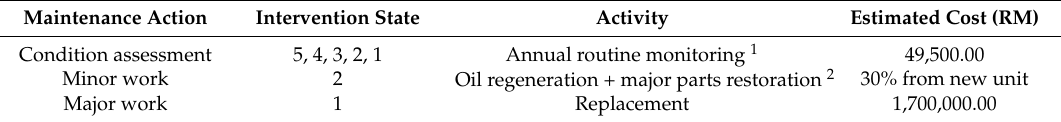
Table 2. Maintenance action, intervention state, maintenance activity and cost estimation